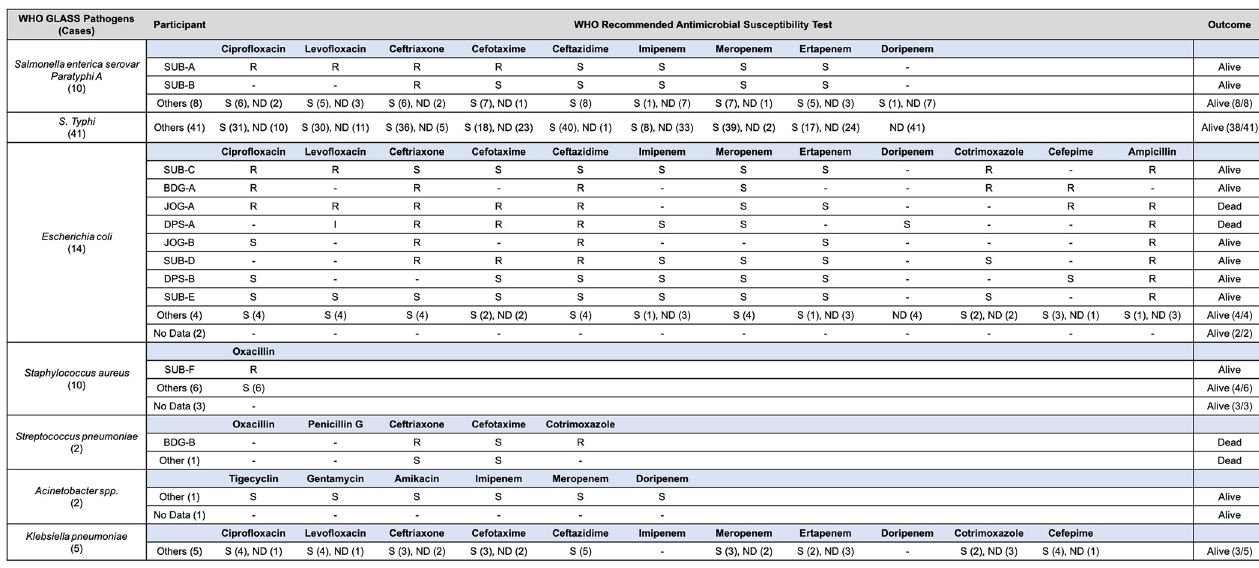
Fig 2. Antimicrobial resistance patterns observed in WHO GLASS priority pathogens from true positive blood cultures. Participants with resistant (R) infections are identified by study location, and participants with sensitive (S) infections or infections with no testing data (ND) are grouped into Other or No Data